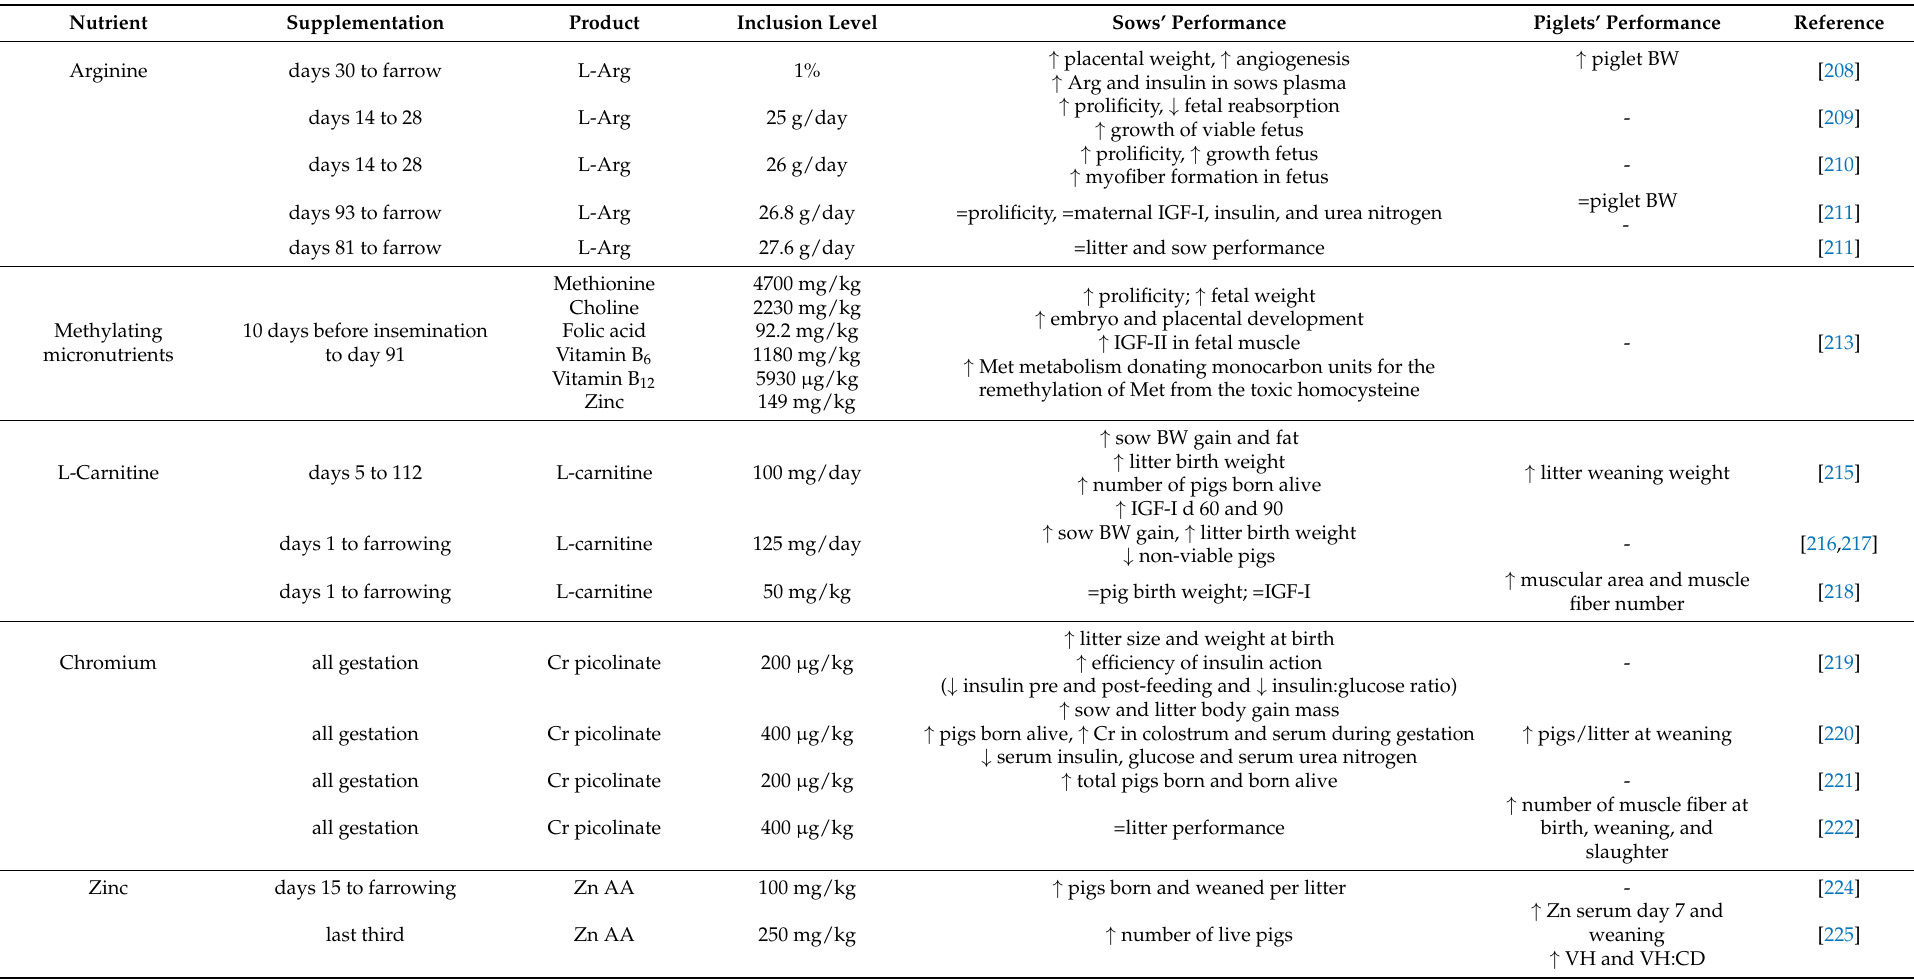
Table 3. Effects of early nutritional intervention during gestation to enhance fetal